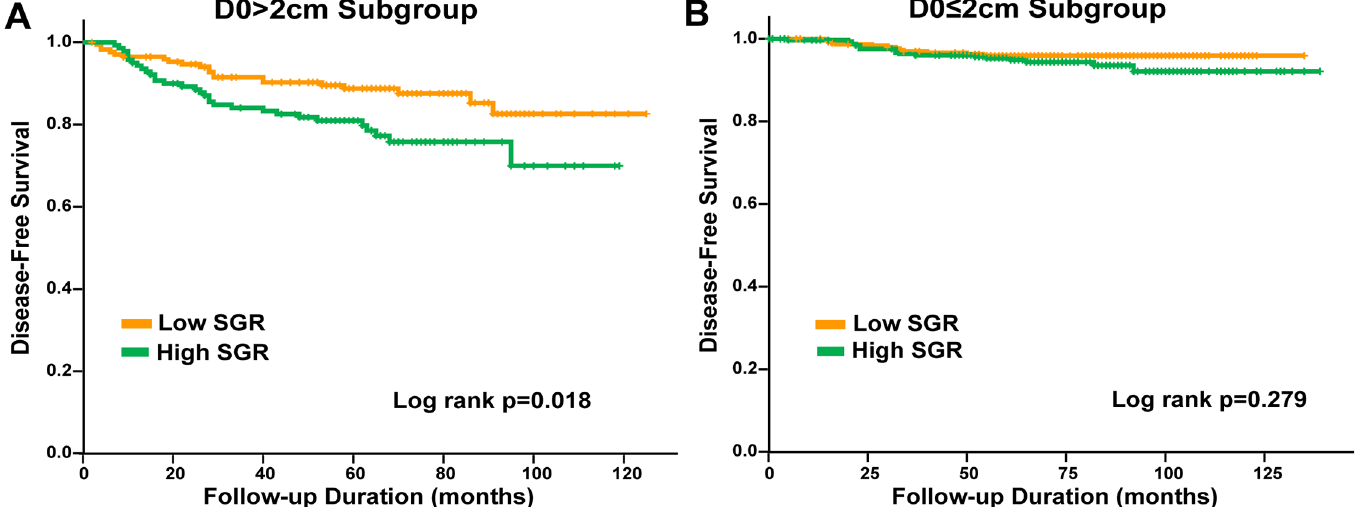
Fig 3. DFS by initial tumor size (D 0 ). (A) DFS according to low and high SGR in D 0 (cid:5) 2cm subgroup (log rank test p = 0.277). (B) DFS according to low and high SGR in D 0 > 2cm subgroup (log rank test p =